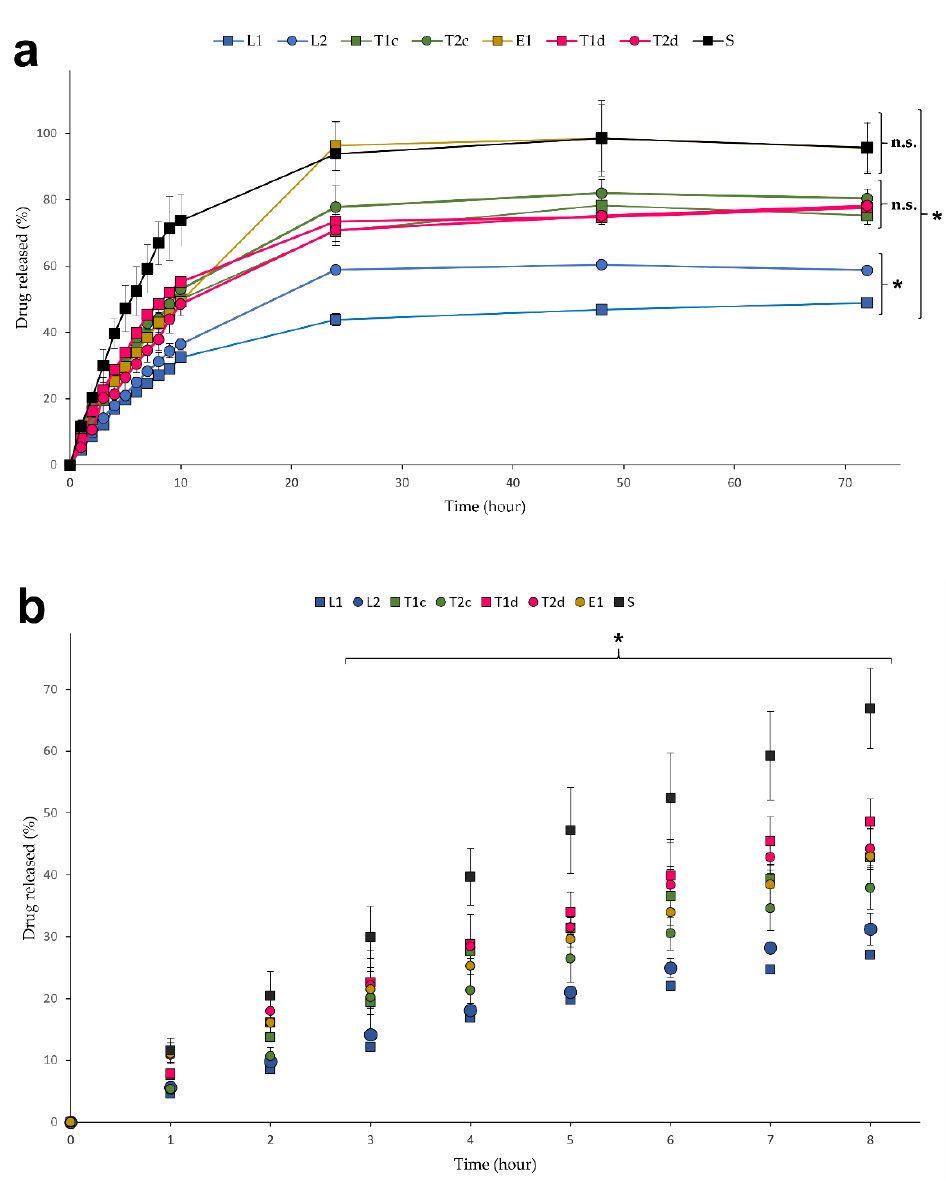
Figure 7. Release profiles from liposomes, transferosomes, ethosomes, and solution after 72 h ( a ) and 8 h ( b ). All results are expressed as mean ± SD ( n = 6). * means statistically significant differences ( p < 0.05), n.s. means no statistically significant differences ( p > 0.05) using two-way ANOVA followed by Bonferroni’s multiple comparison